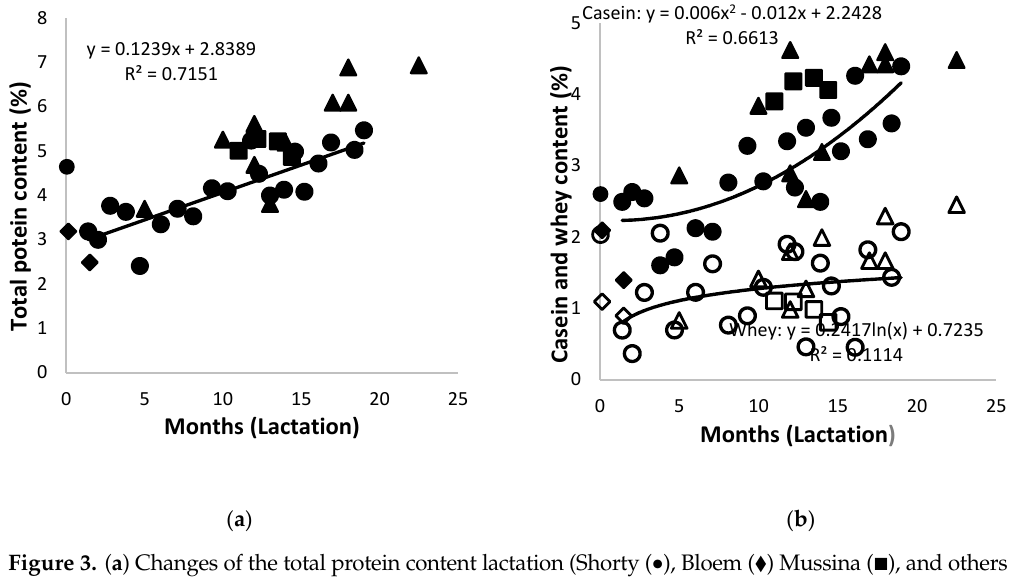
Figure 3. ( a ) Changes of the total protein content lactation (Shorty ( ● ), Bloem ( ♦ ) Mussina ( ■ ), and others ( ▲ )) and ( b ) of casein (solid symbols) and whey proteins (open symbols) in milk of African elephants during lactation (Shorty ( ●○ ), Bloem ( ♦◊ ) Mussina ( ■□ ), and others ( ▲ Δ )). The trend lines for combined data of all elephants were y = 0.0027x 2 + 0.1076x + 2.9055 and R 2 = 0.7153 for total protein, y = 0.126x + 1.8339 and R 2 = 0.6089 for casein, and y = 0.0034x 2 − 0.0243 + 1.0522; andR 2 = 0.2815 for whey.